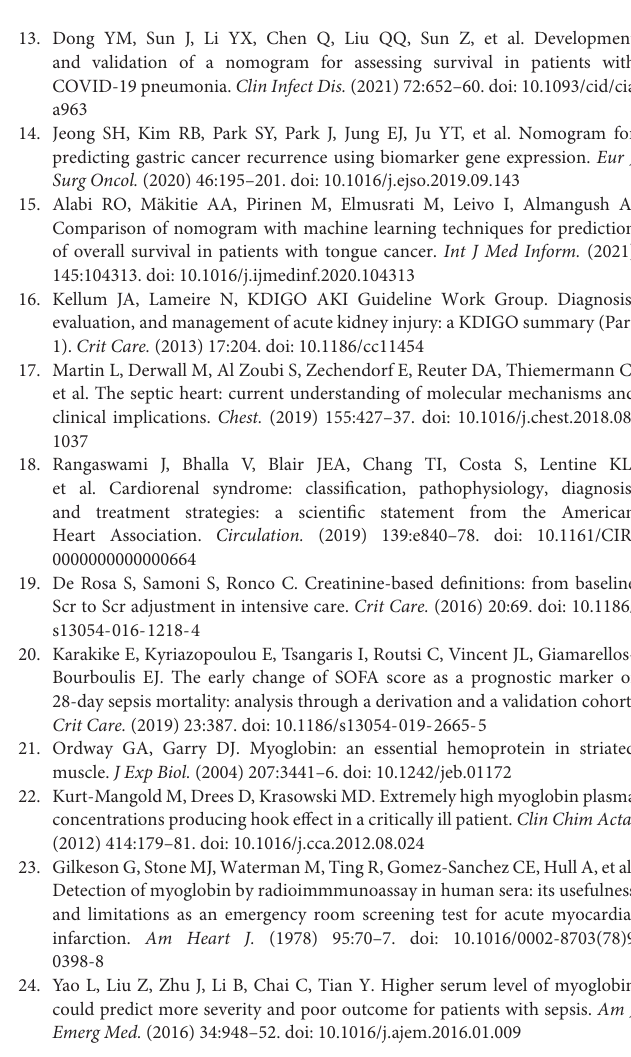
Supplementary Figure 1 | Flow chart illustrating the patient enrollment in validation cohort. Supplementary Figure 2 | The receiver operating characteristic (ROC) curve and calibration curve of nomogram in external validation. (A) The ROC curves of the nomogram; (B) comparison of AUC between the nomogram and SOFA; (C) the calibration curve of the nomogram; (D) comparison of the calibration curves between the ideal model, the nomogram and the bias-corrected model. Supplementary Figure 3 | The decision analysis curves of the nomogram and SOFA in external validation. Supplementary Figure 4 | The ROC curves of machine learning models in external validation. (A) ROC curves of Random Forest; (B) ROC curves of decision